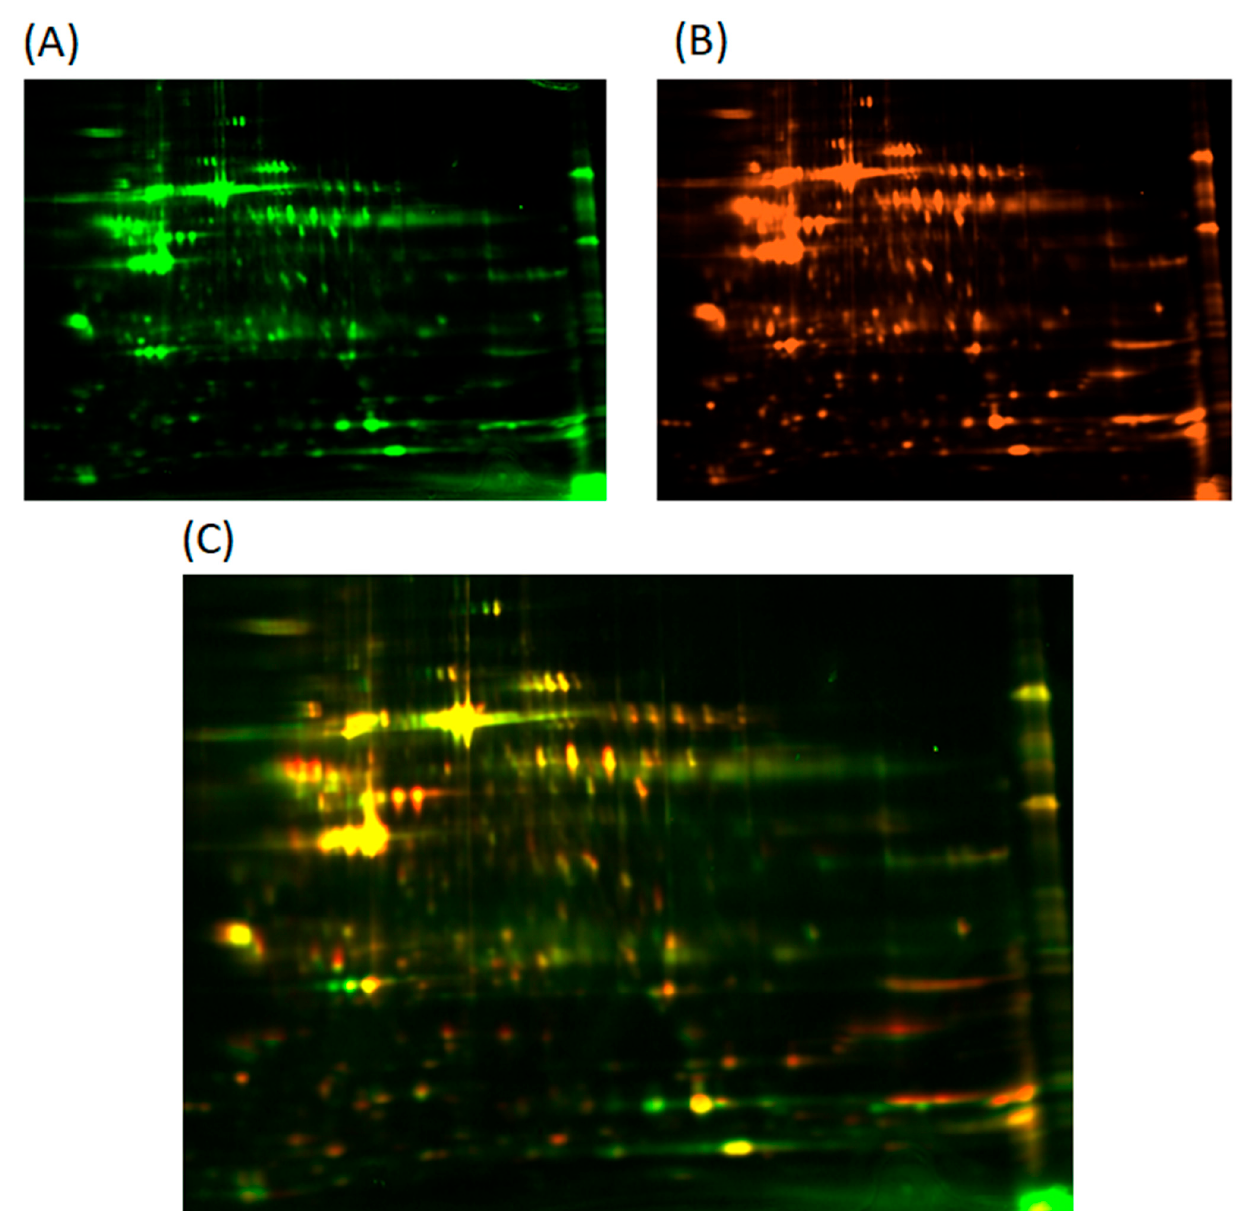
Figure 1. Fluorescently labeled electrophoretic gels of blood platelets proteome obtained from the control group ( A ) and ACS patients ( B ). Merge spots ( C ) represent the comparison between prote- omes.